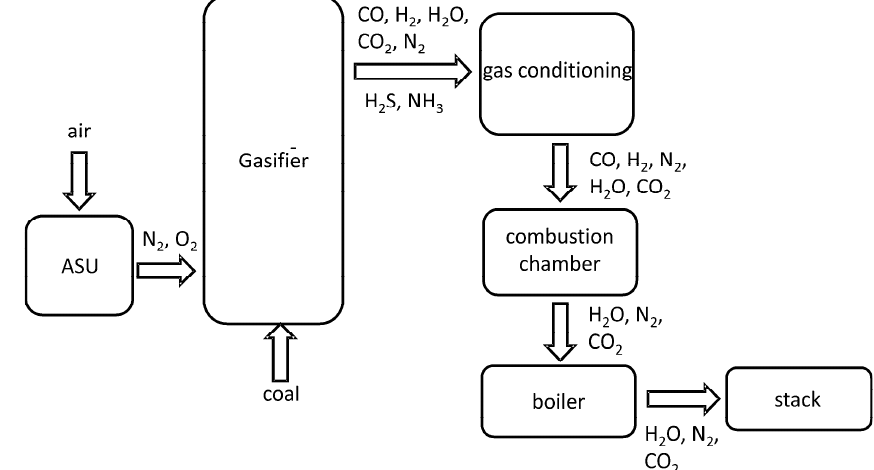
Figure 3. The basic scheme of a coal-fired IGCC plant.